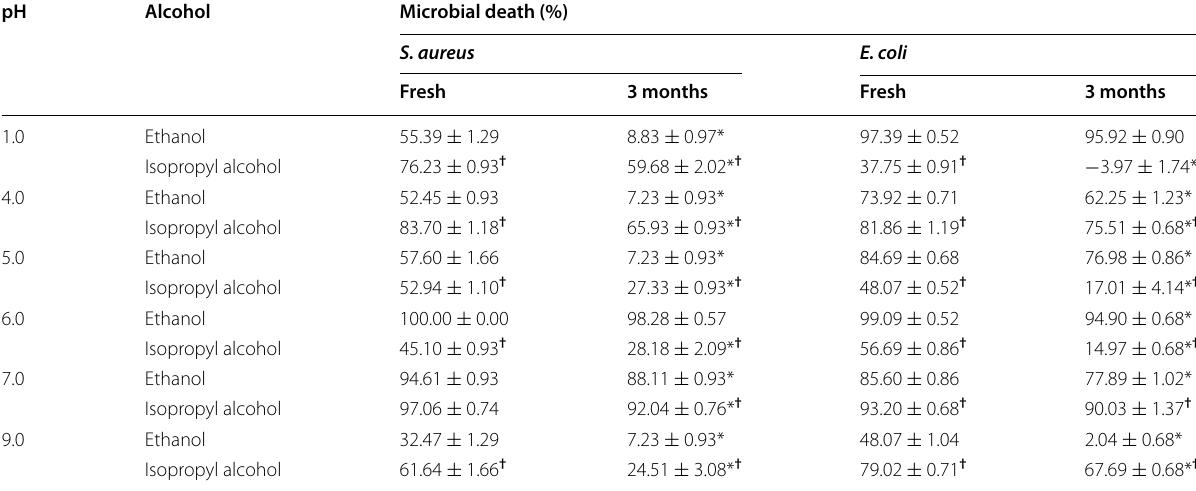
Values represent means SD. Values with * indicate a significant difference ( P < 0.05) from fresh sample for the same alcohol/pH/organism. Values with † indicate a ± significant difference ( P < 0.05) from ethanol for the same pH/organism/test time. N